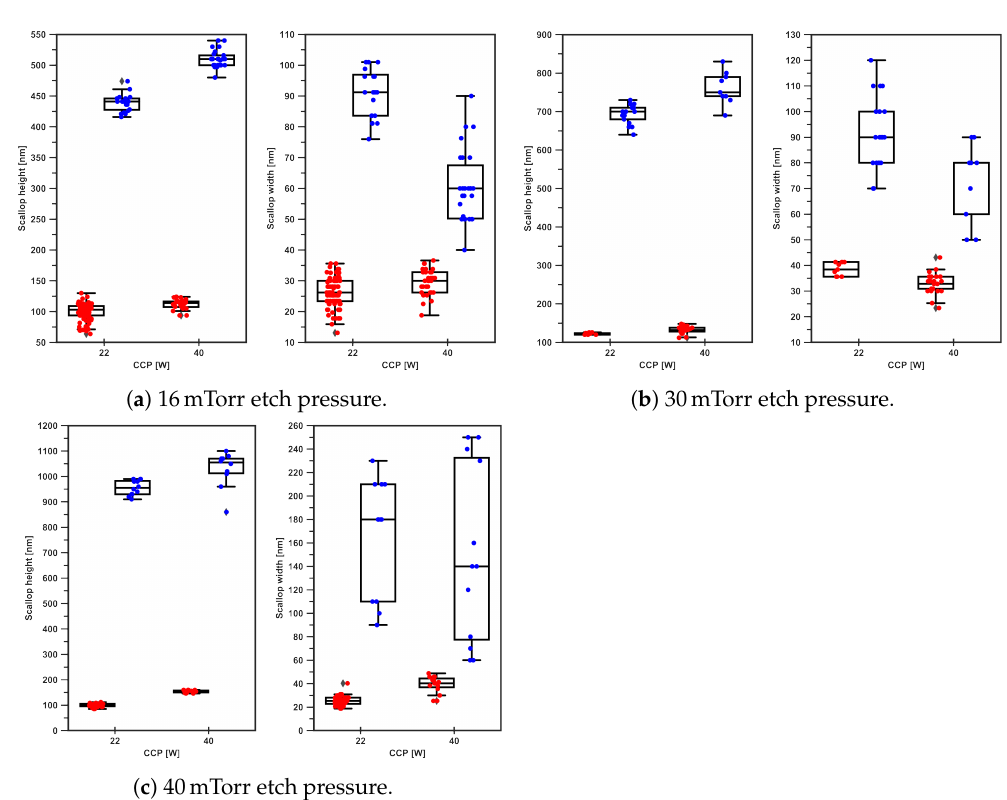
Figure 13. Graphs displaying the scallop height and width in nanometres as functions of etch-cycle time (1.5 and 5.0s), process pressures (16, 30, and 40mTorr), and CCP LF settings (22 and 40W). The colours correspond to: = 1.5s and =